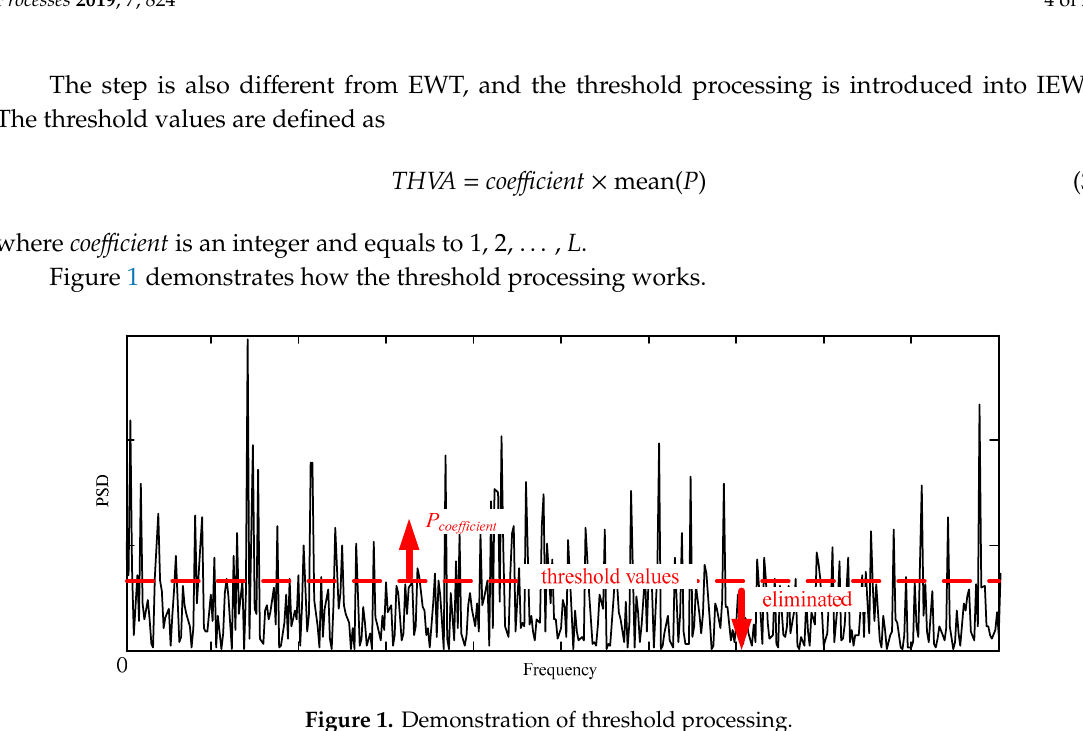
Figure 1. Demonstration of threshold processing.